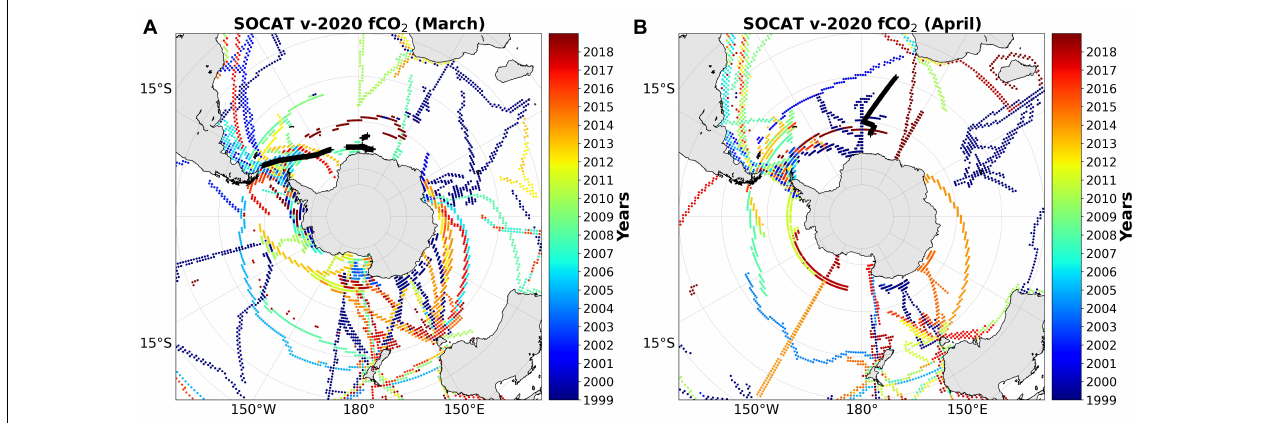
FIGURE 2 | Map of available fCO 2 observations during autumn (March/April) in SOCAT v-2020 (Bakker et al., 2016, 2020) for the Southern Ocean from 1999 through 2019. Few years of observation are available in the Weddell gyre region the focus for this study (study transect; black color) relative to other regions in the Southern Ocean. (A) Years with available fCO 2 observations for March. (B) Years with available fCO 2 observations for